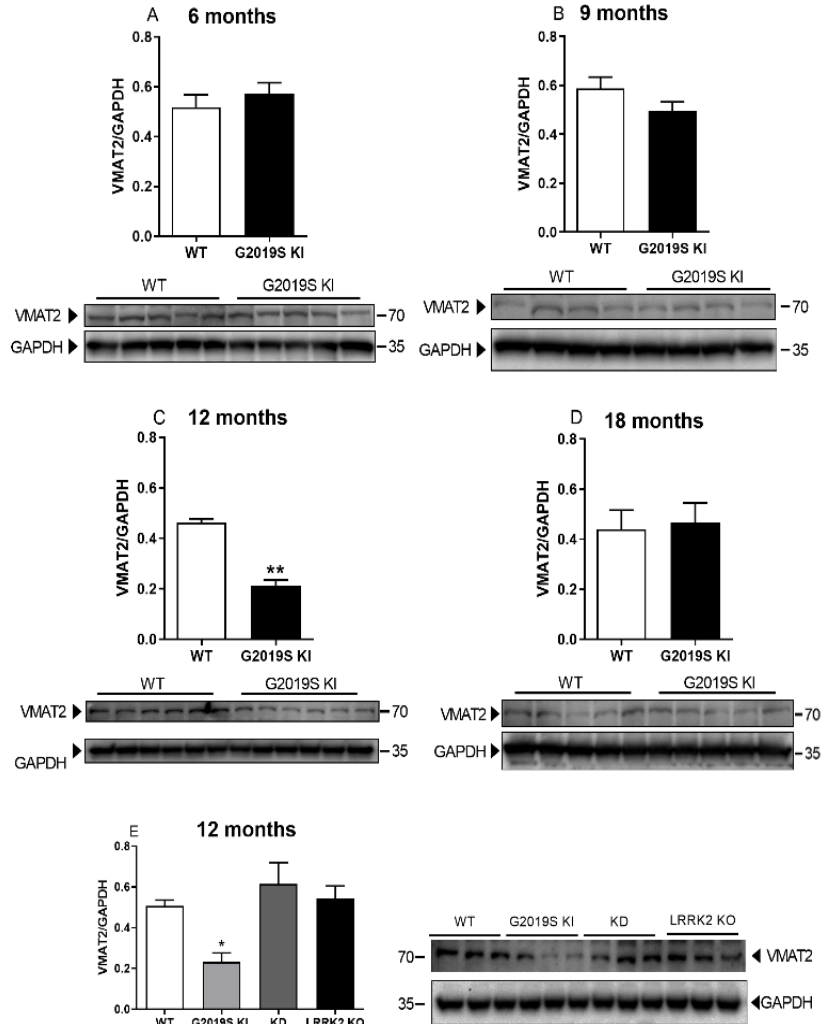
Figure 4. The reduction of VMAT2 levels in G2019S KI mice appears at 12 months and is associated with the G2019S mutation. Western blot analysis of VMAT2 levels in the striatum of 6-month-old ( A ), 9-month-old ( B ), 12-month-old ( C ) and 18-month-old ( D ) G2019S KI mice versus age-matched WT controls, and representative blots. ( E ) Western blot analysis of VMAT2 levels in the striatum of 12-month-old G2019S KI mice versus age-matched LRRK2 KO, KD and WT mice, and representative blots. Data are expressed as mean ± SEM of n = 6 animals per group. Statistical analysis was performed using the Student t -test, two-tailed for unpaired data (A – D) or one-way ANOVA (E) followed by the Tukey test for multiple comparisons. * p < 0.05, ** p < 0.01 different from WT.